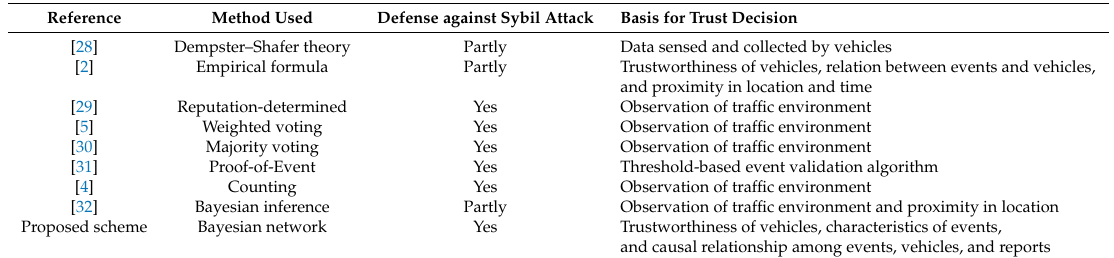
Table 1. Comparison of the proposed trust model with the existing